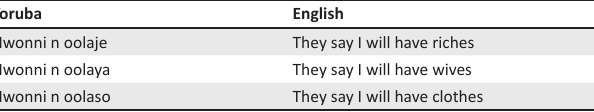
TABLE 3: Potent words to make one rich by mere pronouncement in